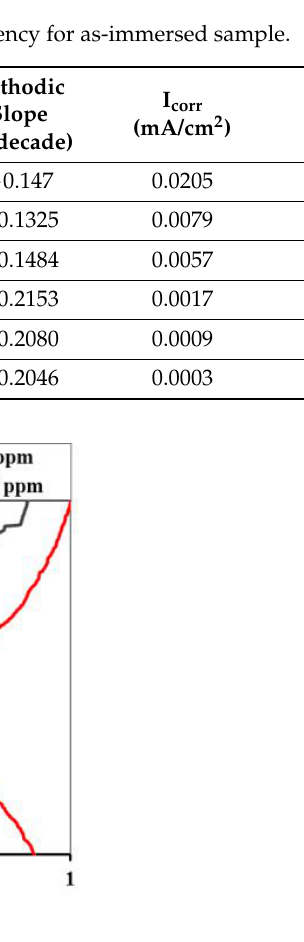
Figure 8. Potentiodynamic polarization curves for mild steel in 1 M H 2 SO 4 containing different